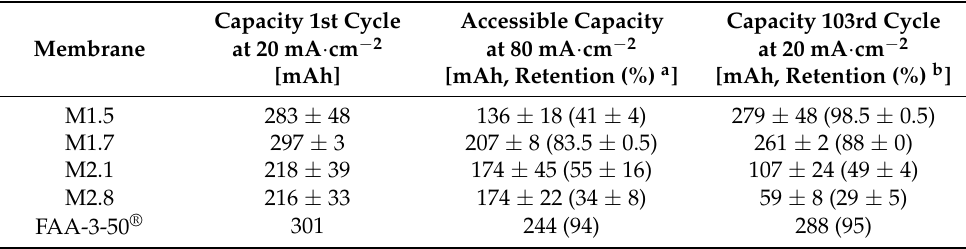
Table 4. Summary of initial capacity and capacity retention of the prepared AEMs and commercial membrane FAA-3-50 ® at 20 and 80 mA · cm − 2 .